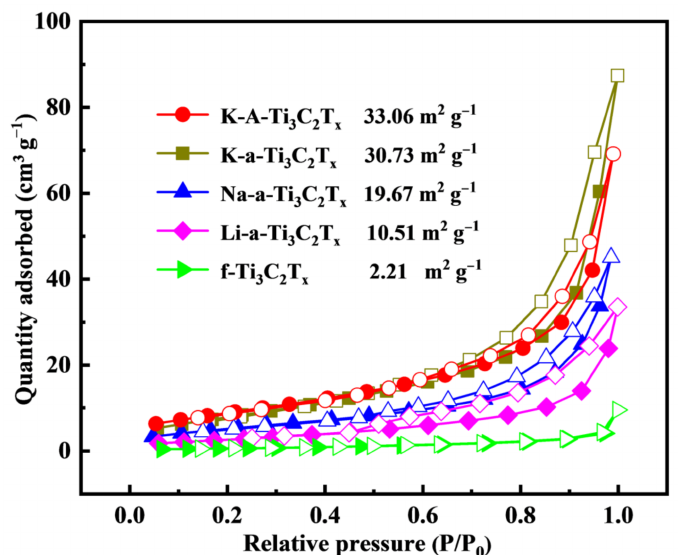
Figure 7. N 2 adsorption–desorption isotherms of f-Ti 3 C 2 T x , K-a-Ti 3 C 2 T x , Na-a-Ti 3 C 2 T x , Li-a-Ti 3 C 2 T x , and K-A-Ti 3 C 2 T x